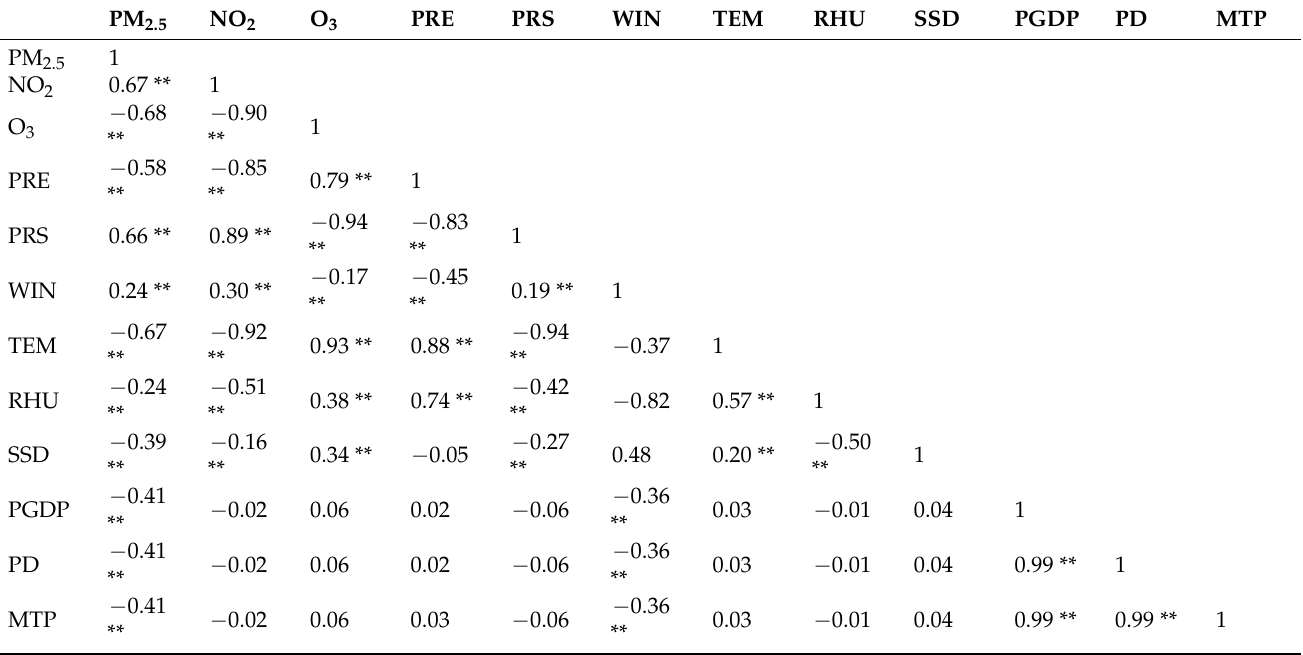
Table 2. Spearman correlation coefficients among ambient air pollutants and climatic